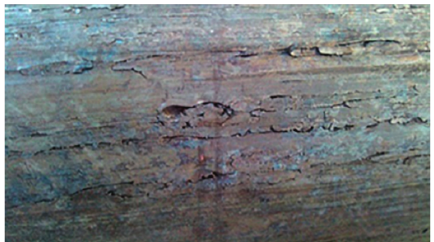
Figure 1: Surface morphology of Inconel 625 superalloy after extrusion.